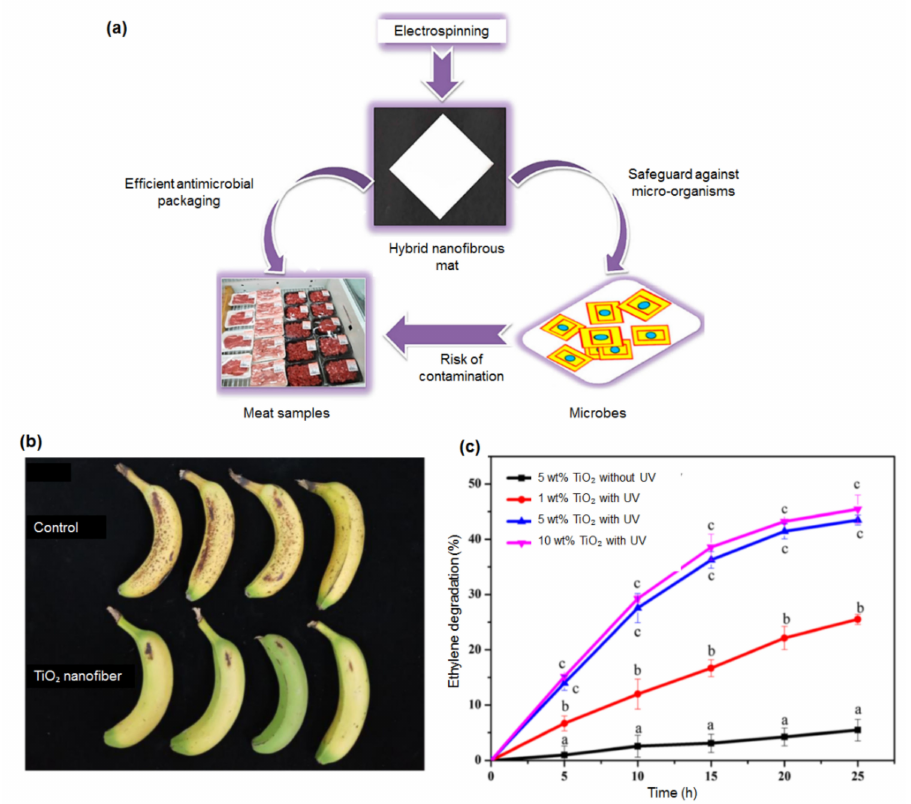
Figure 7. ( a ) Packaging material made of electrospun hybrid mats targeting for meat and meat-based products. ( b ) Photographs of bananas stored for 10 days covered with PP film (control) and nanofibers containing 5 wt% TiO 2 . ( c ) Ethylene photodegradation activity of a TiO 2 /PP nanofiber-based film. Figures are adapted and modified from